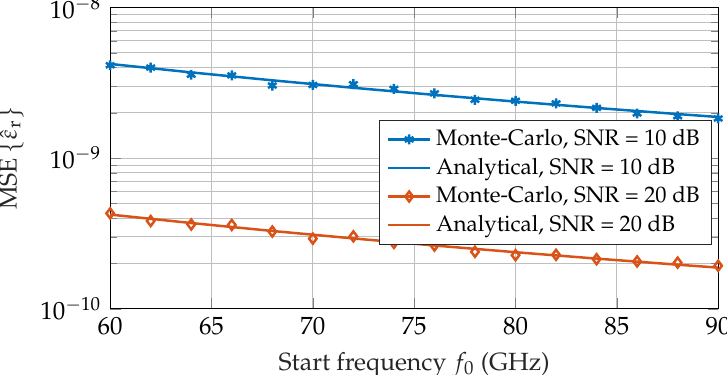
Figure 1. Monte-Carlo simulation of the mean square error MSE { ε r } for N = 4096, f 0 = 77 GHz and air reference ε r,ref = 1.000536. The length of the propagation path in the medium under test (MUT) d m is varied in the range 0.1–2.0 m.